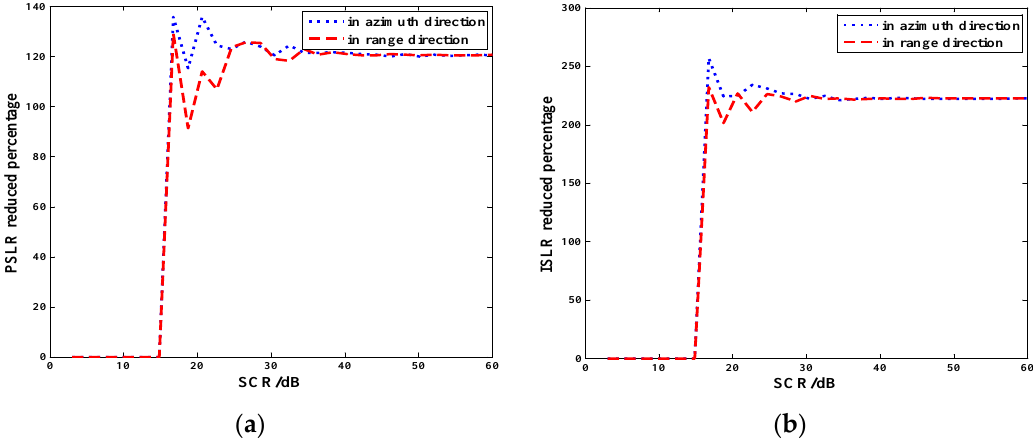
Figure 5. Sidelobes reduced percentage as a function of SCR for a single point target ( a ) PSLR reduced percentage for different SCRs; ( b ) ISLR reduced percentage for different SCRs.